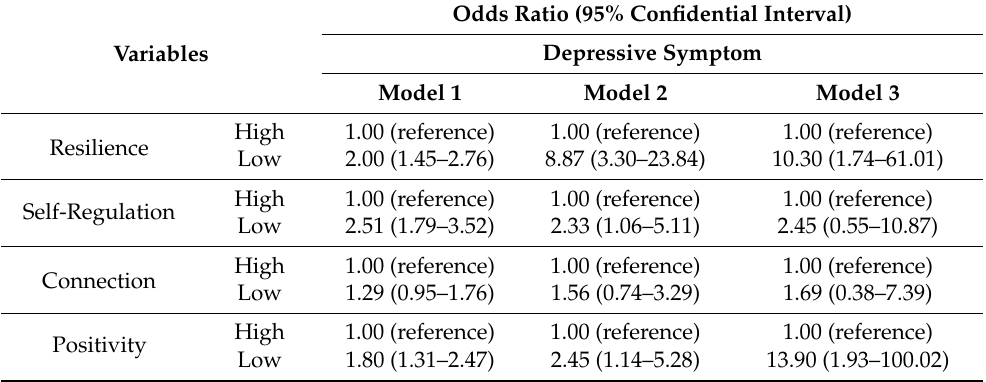
Table 3. Association of resilience and depressive